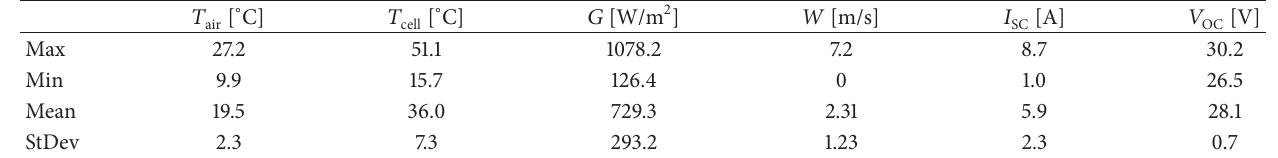
Table 3: Preliminary statistics evaluation of weather, thermal, and electric data pertaining Kyocera panel.